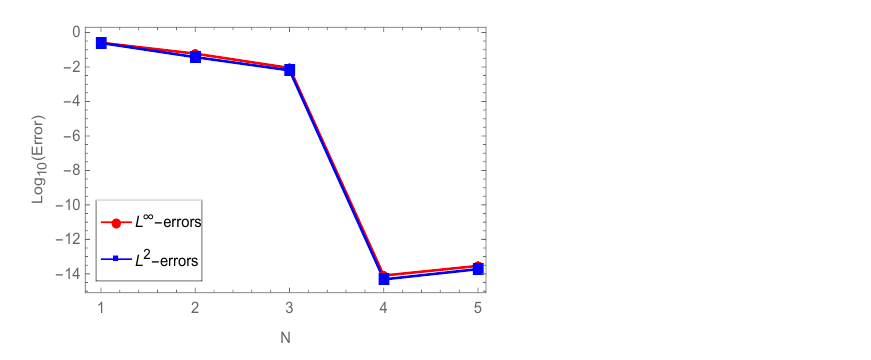
Figure 2. Log 10 ( L ∞ − errors ) and Log 10 ( L 2 − errors ) of our algorithm at υ 1 = 0.25 and b = 2 with distinct N for Example